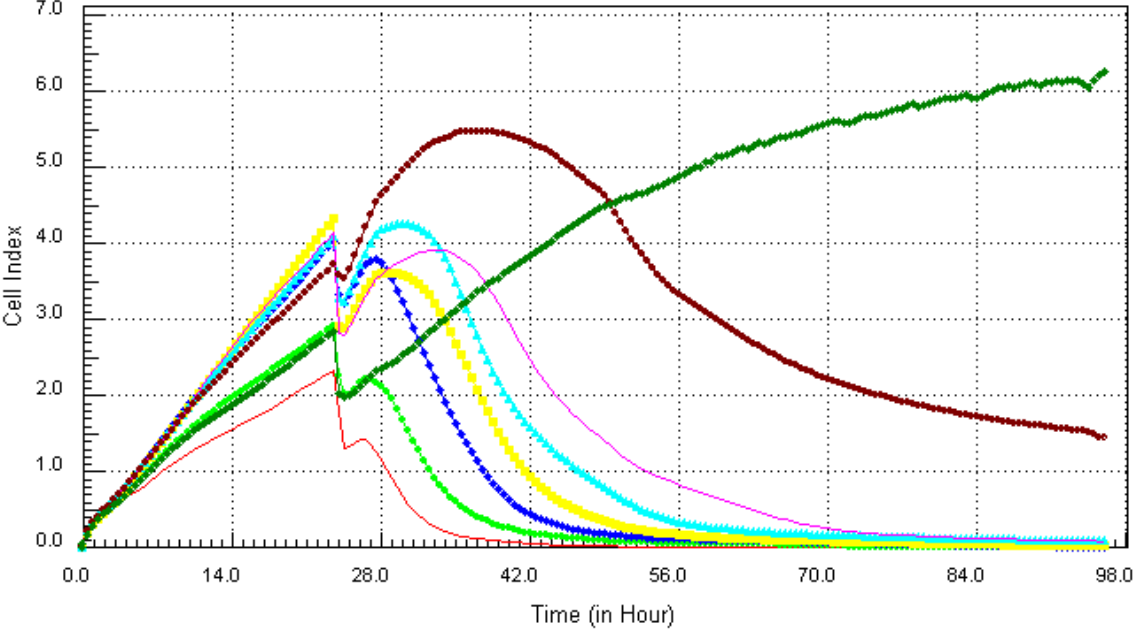
Figure 7. Kinetics of cytotoxic responses for arsenic in LBSO-treated MCF7 cells as described in Figure 6 legend.